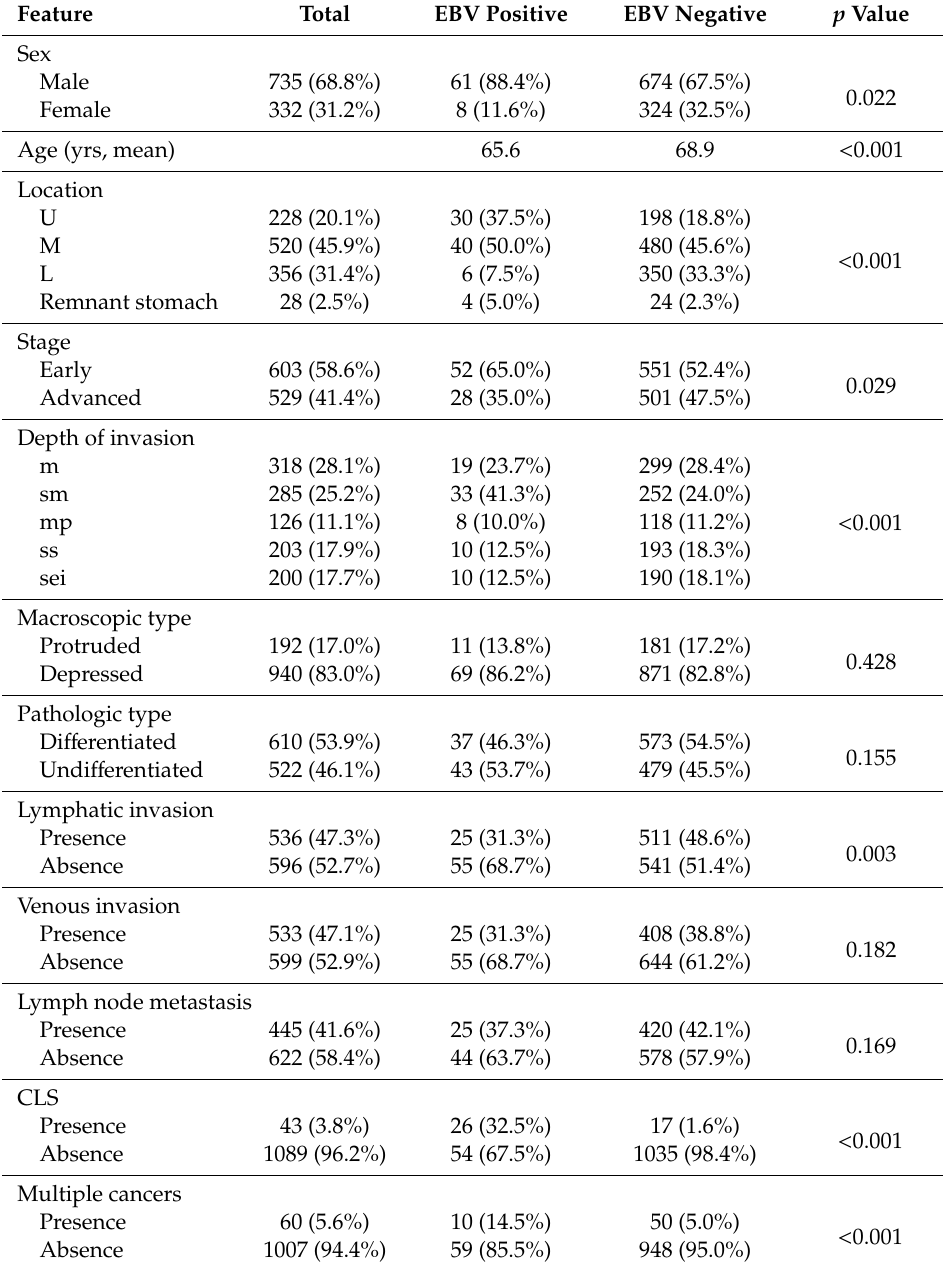
Table 1. Clinicopathologic features of Epstein–Barr virus (EBV)-associated gastric